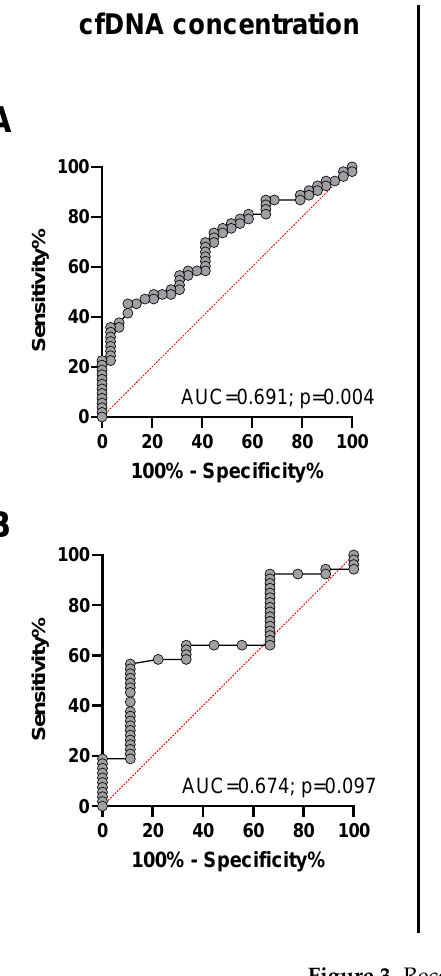
Figure 3. Receiver operating characteristic (ROC) curves to distinguish between healthy controls and patients with advanced NEN disease ( A ) and between presumably cured NEN patients and patients with advanced NEN ( B ) for cfDNA concentration ( left ), percentage of cfDNA hypomethylation ( middle ), and cfDNA integrity ( right ).